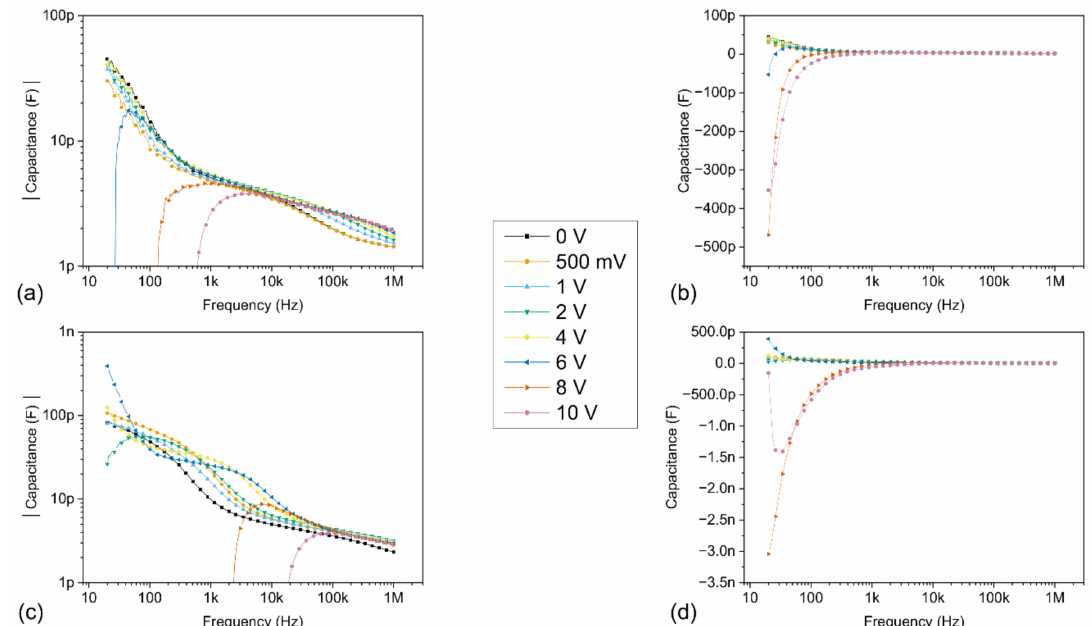
Figure 11. (C-f) characteristics under dark and light conditions for different fixed bias voltages ranging between 0 V and 10 V. The frequency was varied with a logarithmic sweep between 20 Hz and 1 MHz; ( a ) log scale under dark conditions; ( b ) linear scale under dark conditions; ( c ) log scale under light conditions; ( d ) linear scale under light conditions. Only the positive capacitance values are displayed in the graphs ( a , c ) with a log